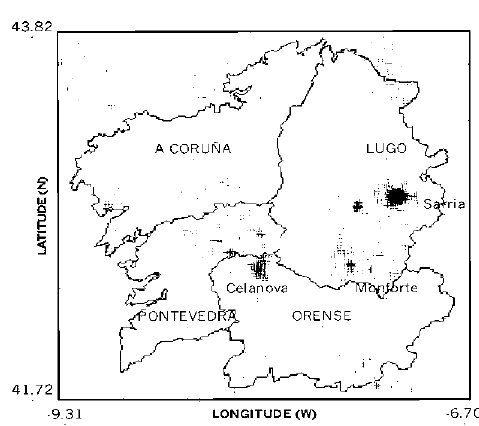
Fig. 11. Sequence graph of time intervals between consecutive cluster members.